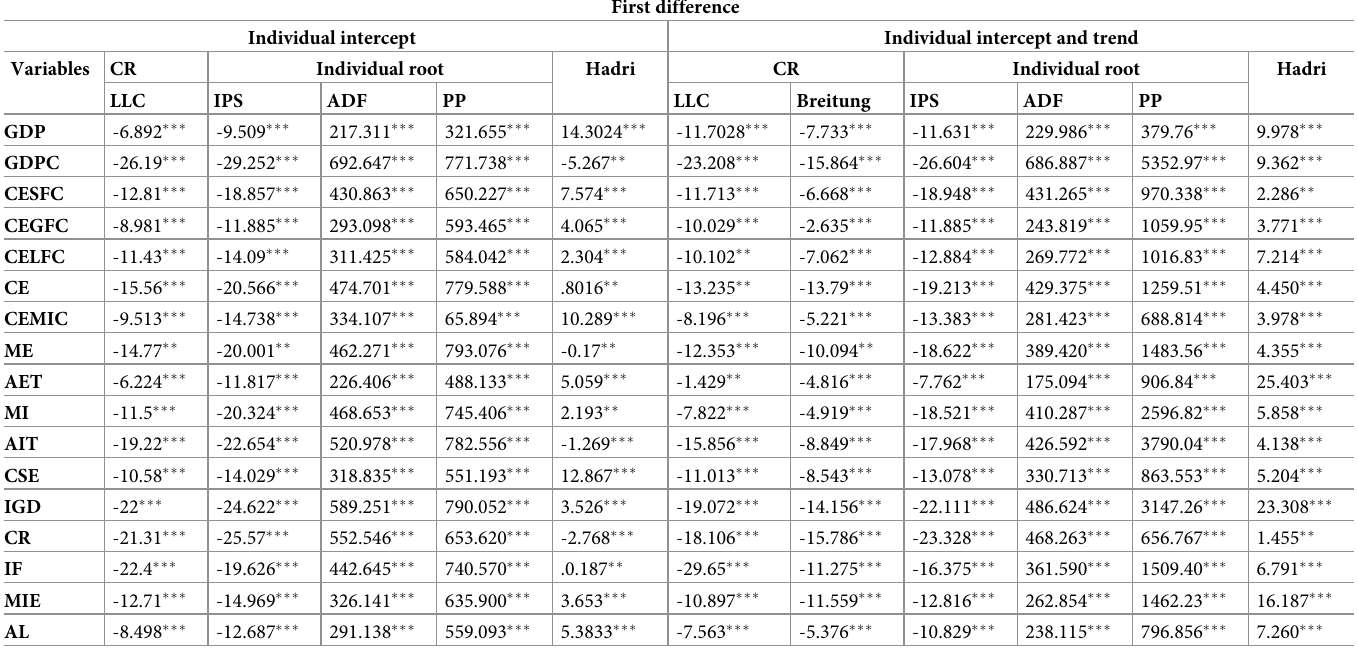
Table 8. Unit root of individual variables (first